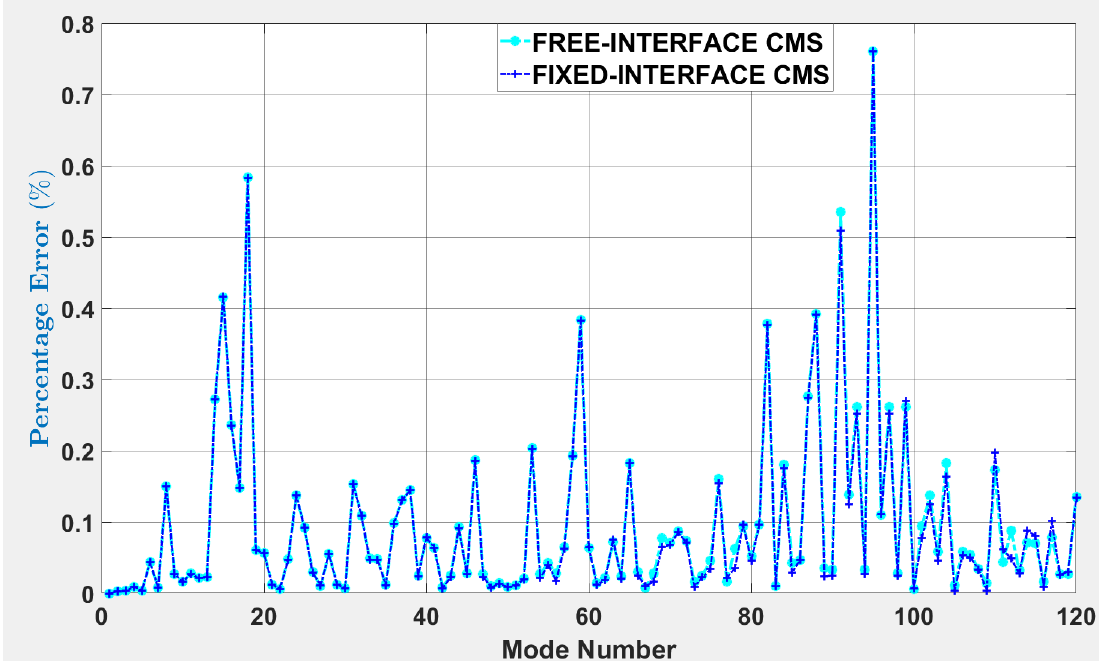
Figure 2. Percentage deviations of